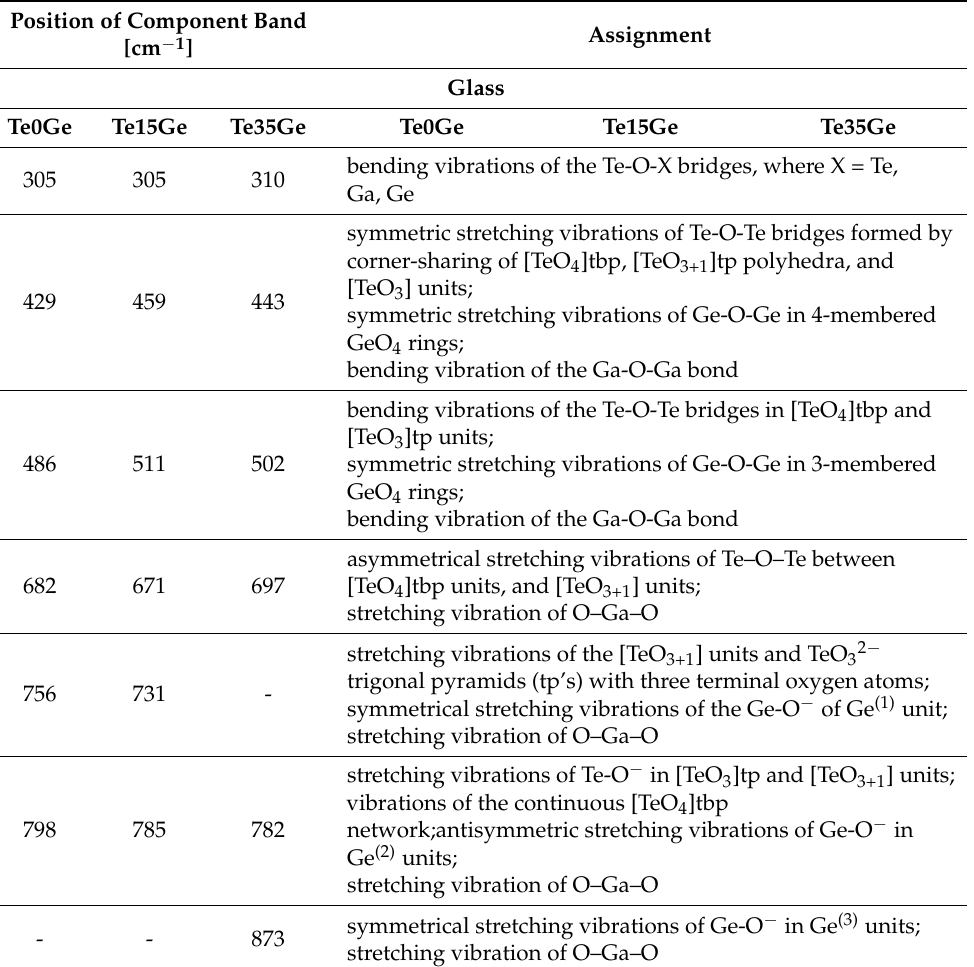
Table 3. Assignment of component bands in Raman spectra of the selected glasses doped with Eu 3+